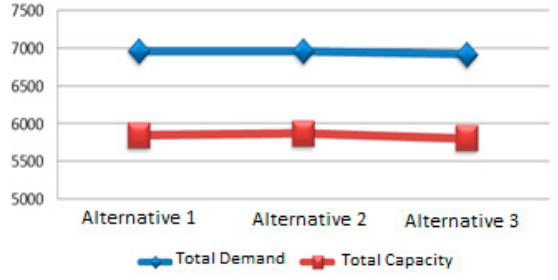
Figure 10. Comparison of alternatives.